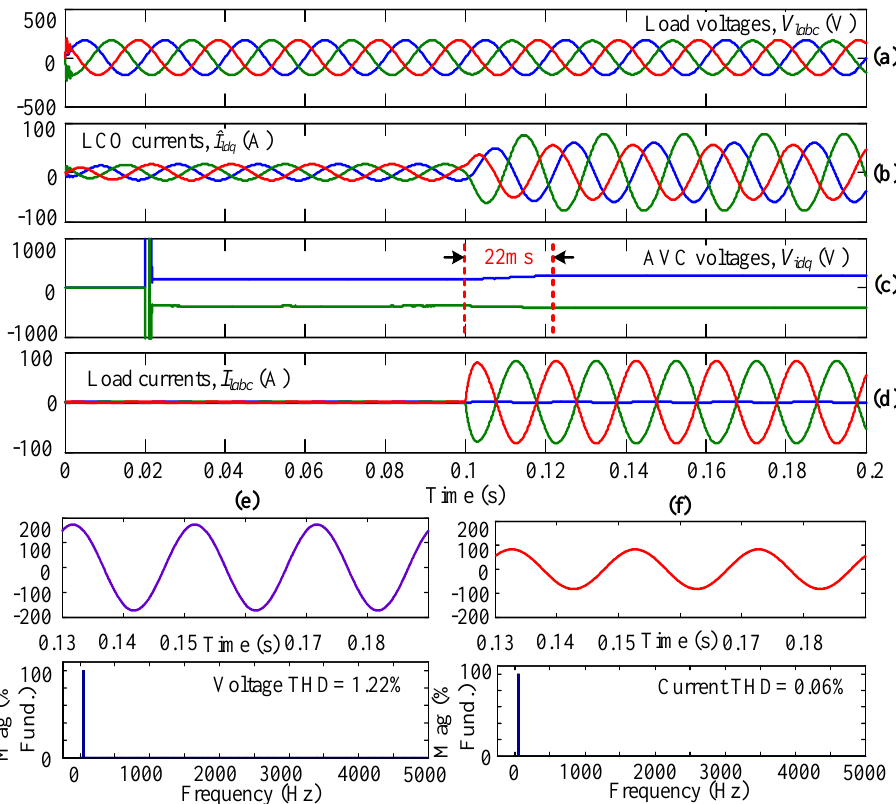
Figure 8. Simulation results for case-II with unbalanced load condition.